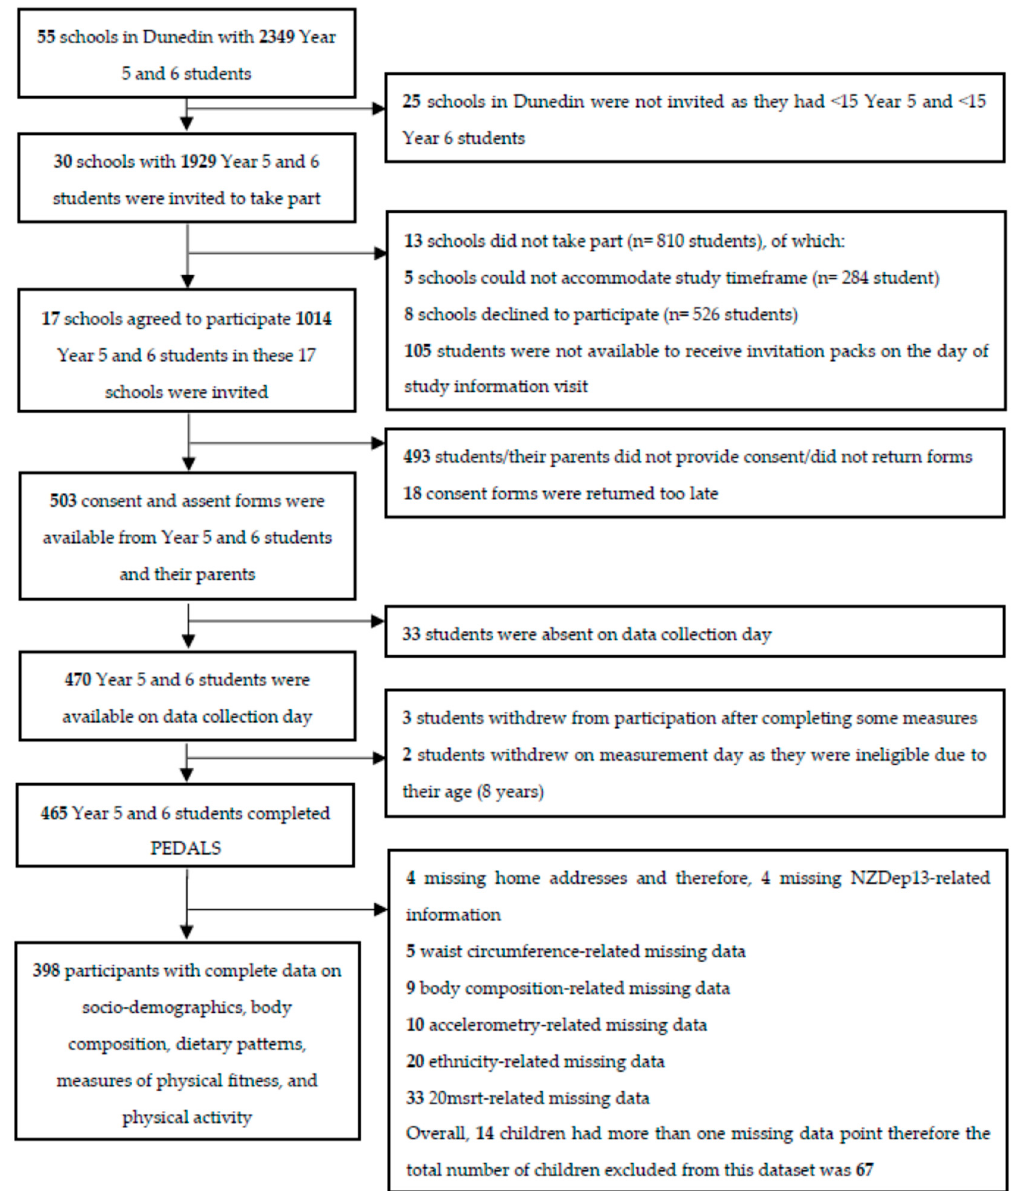
Figure 1. Flowchart illustrating the selection of schools and children into the Physical activity, Exercise, Diet And Lifestyle Study (PEDALS). NZDep13, New Zealand deprivation index.